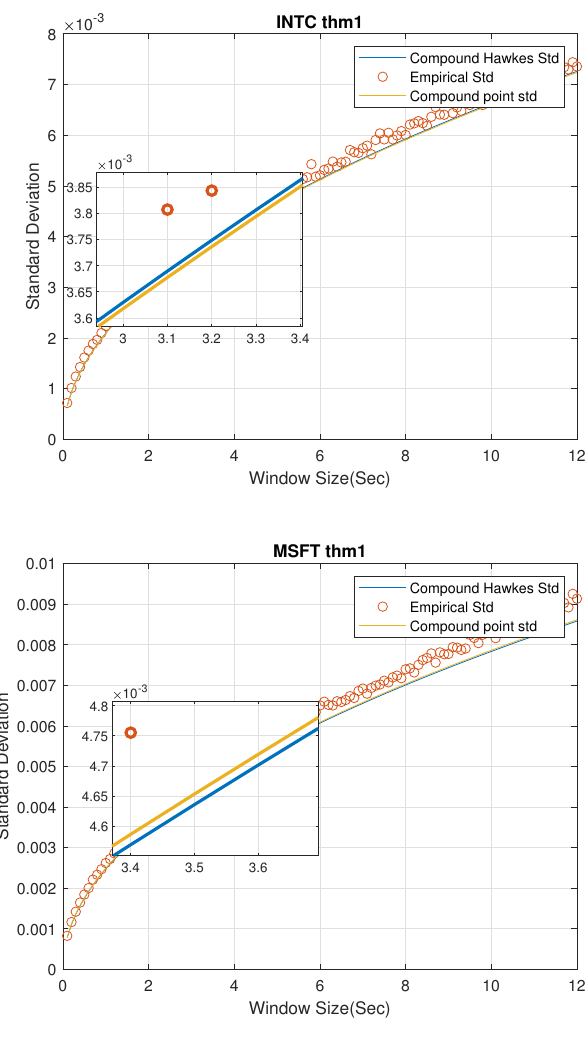
Figure 1. Standard deviation comparisons for 2 stocks by FCLT I for multivariate general compound point process (MGCPP) and multivariate general compound Hawkes process